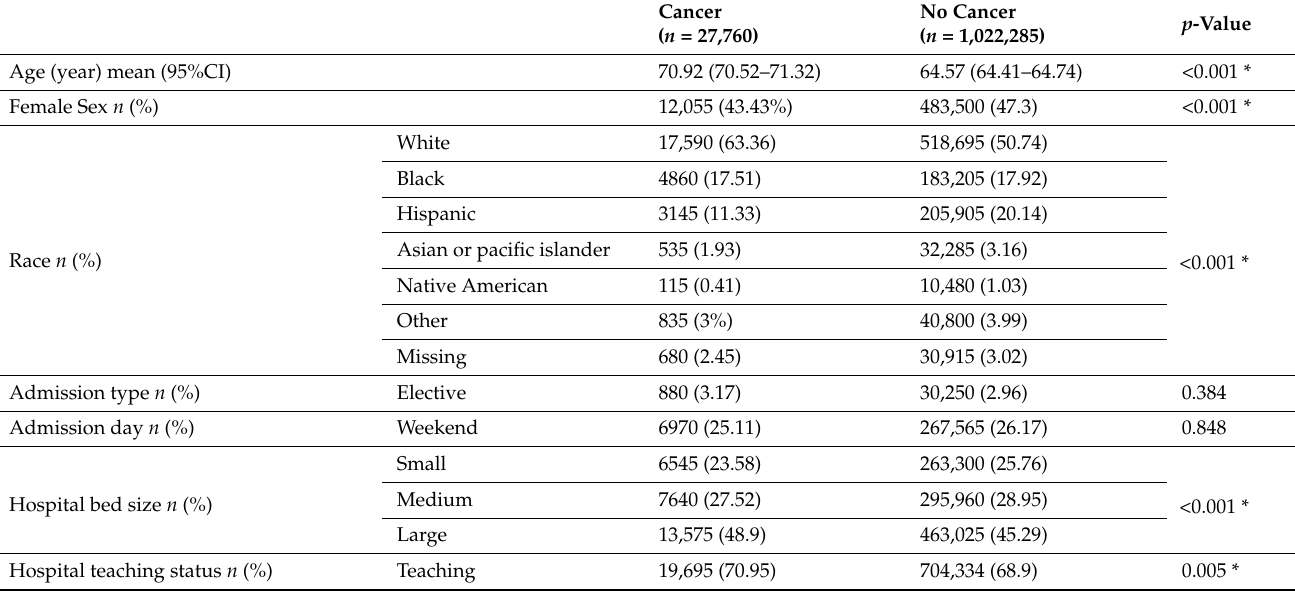
Figure 1. Selection of study subjects. Table 1. Summary of patients and hospitals characteristics.